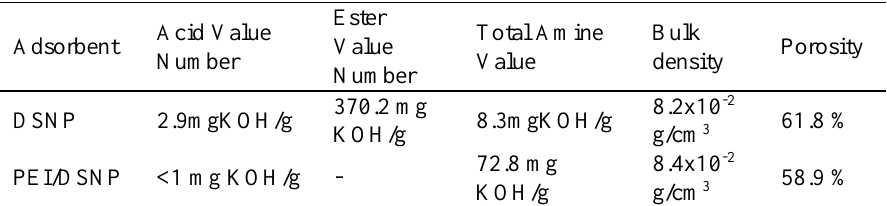
Table 1. Acid, ester number, total amine number, bulk density and porosity of DSNP and PEI/DSNP